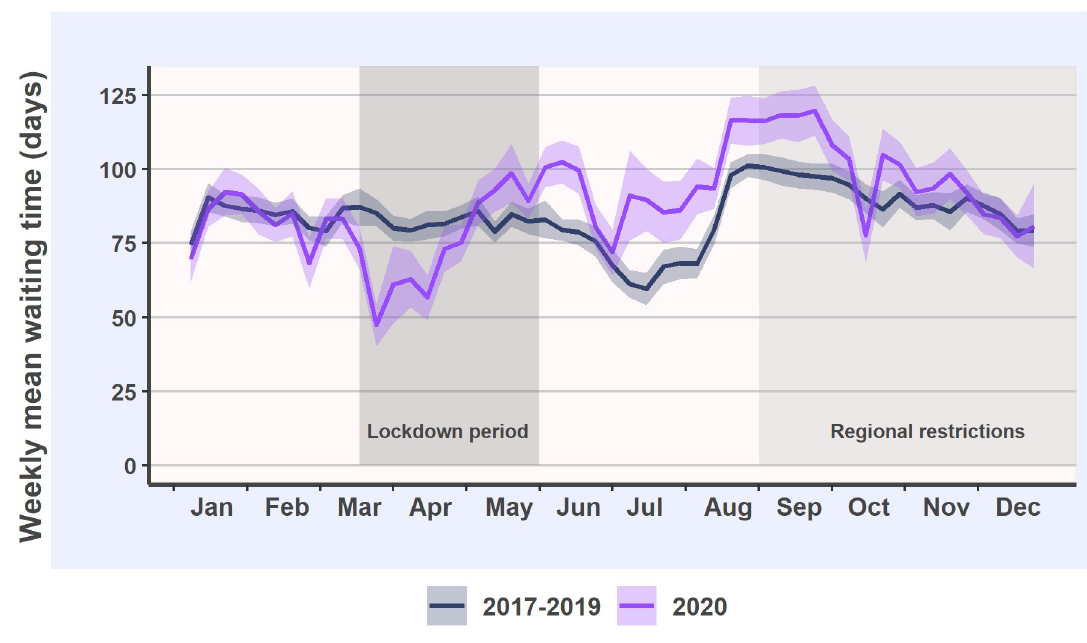
Fig 2. Weekly mean and 95% confidence intervals of elective surgery waiting times in 2020 and the reference years.